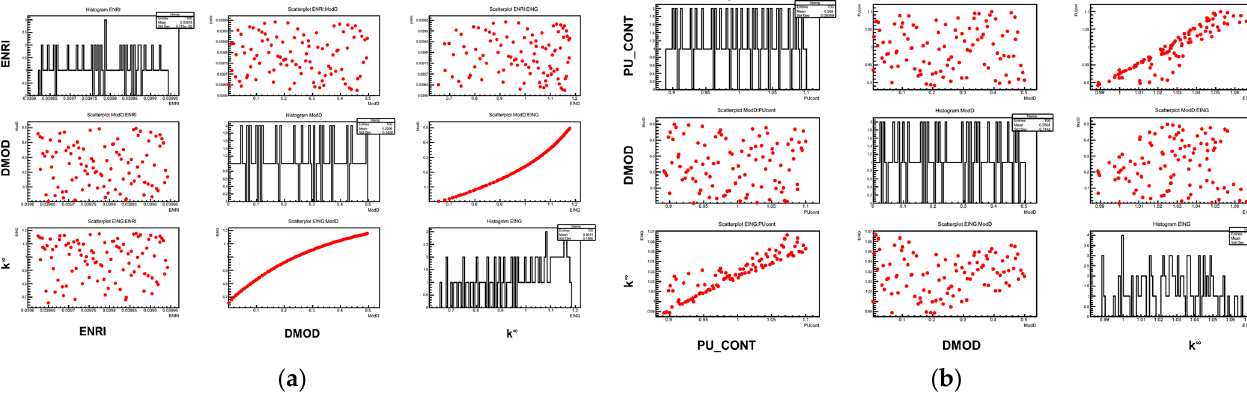
Figure 14. Pairs plot (PU_CONTENT/ENRI, DMOD): ( a ) PWR UOX CELL; ( b ) PWR MOX CELL. HEXAGONAL UOX CELL